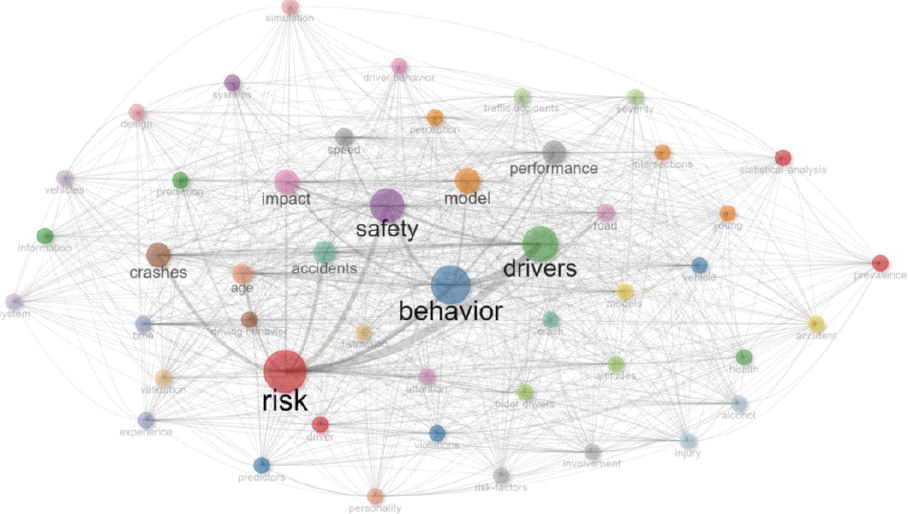
Figure 8. Co-occurrence network: Africa. Source: Author’s own, based on Web of Science search.